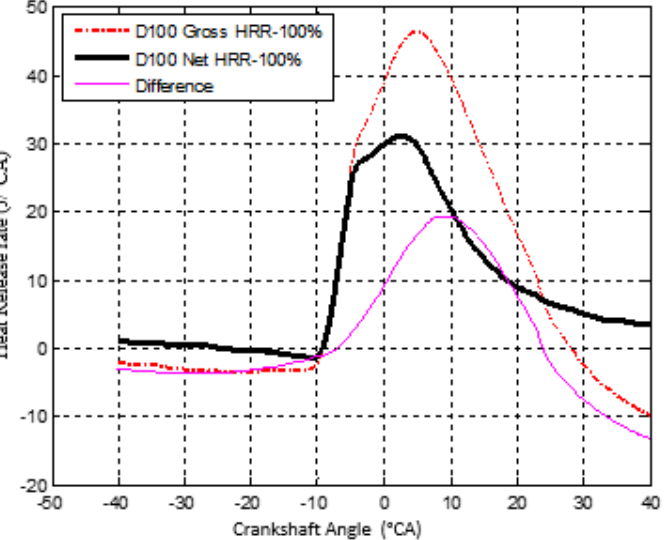
Figure 9. Profile of net heat release rate (Net HRR) evolution and gross heat release rate (Gross HRR) for engine speed n = 1500 rpm at 100% load according to D100 combustion.